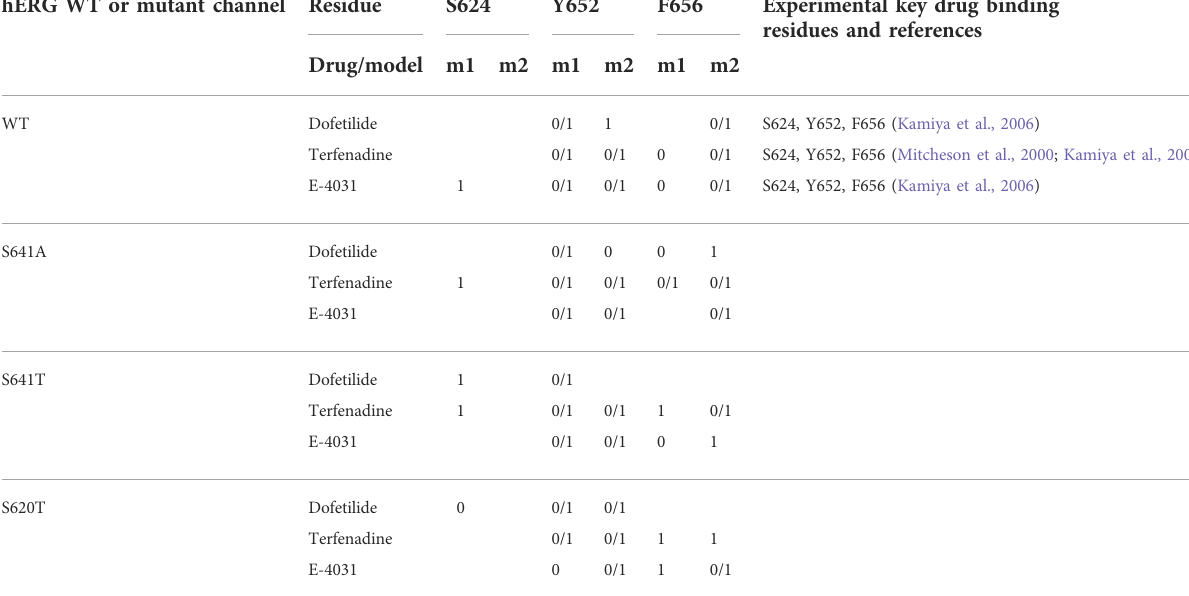
TABLE 1 Key drug binding residues (S624, Y652, and F656) for top-ranked drug binding poses to hERG m1 and m2 model WT and mutant channels from Rosetta Ligand and previously published electrophysiology experiments (adopted and modi fi ed from Negami et al. (2019)). hERG WT or mutant channel Residue Experimental key drug binding residues and